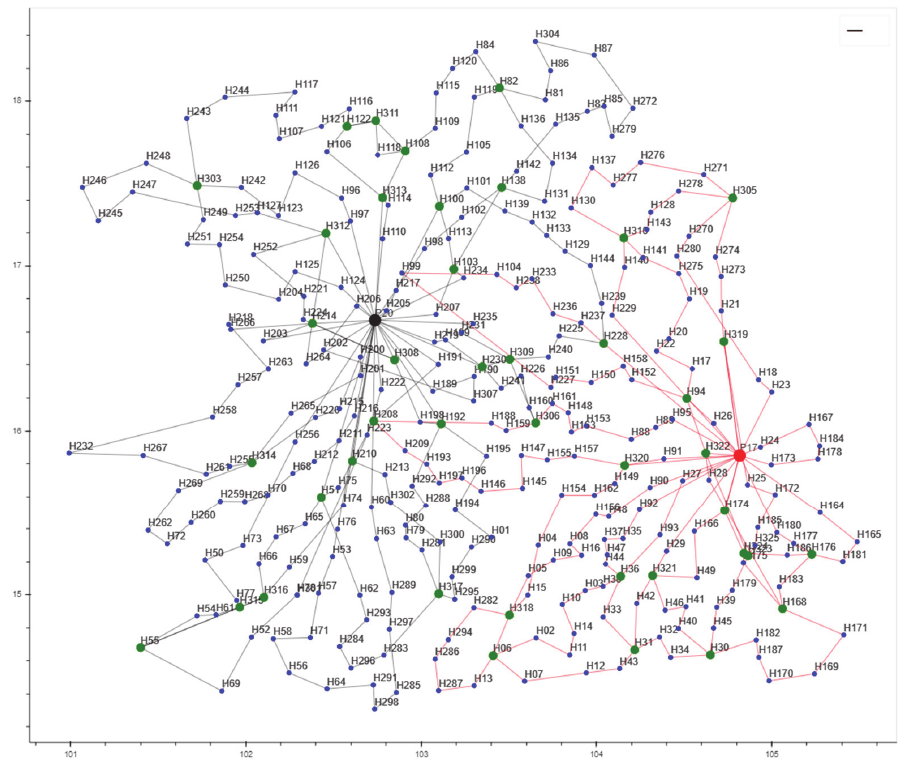
Fig. 4. Suitable location of incinerators and vehicle routing for the infectious waste collection of hospitals in the Northeast of